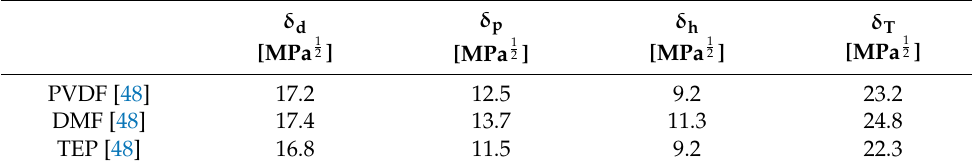
Table 3. Hansen solubility parameters of PVDF, DMF, and